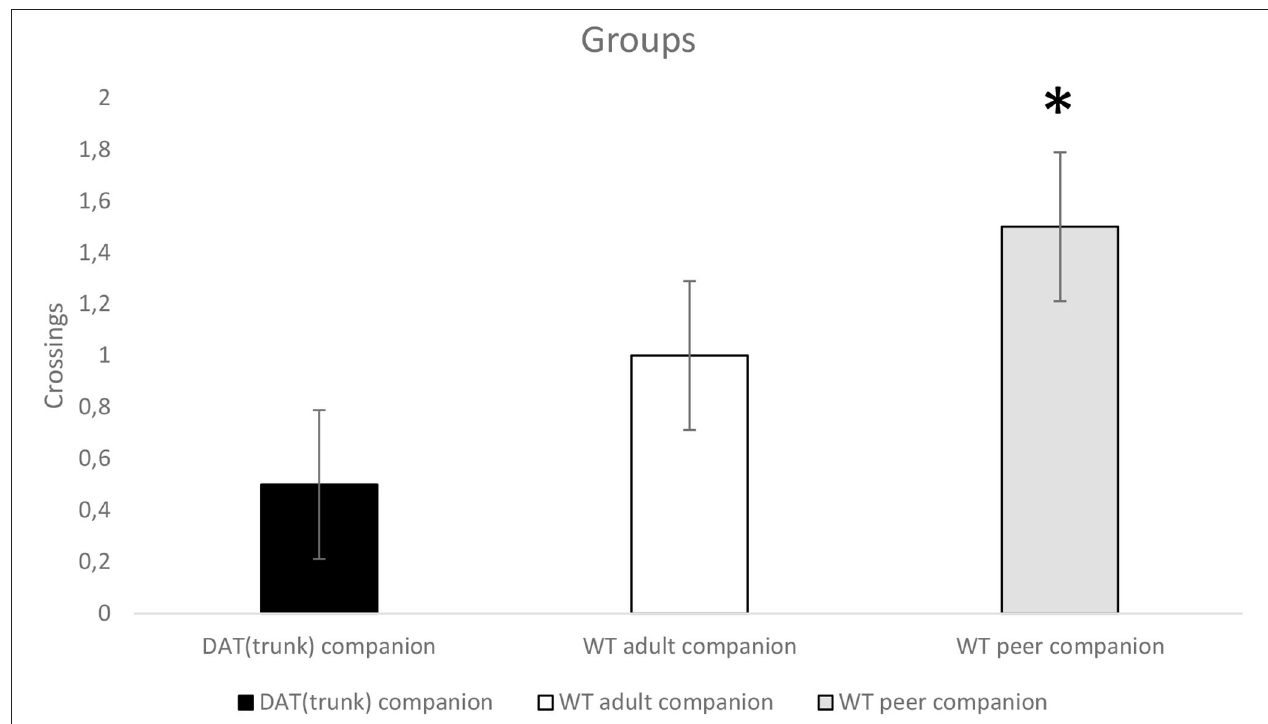
FIGURE 4 | Wild-type (WT) adolescent rats grown up with WT adolescent rats (gray) ( n = 8) cross more (* p < 0.06) than WT rats grown up with DAT trunk rats (black) ( n = 8) when they faced up both the 99-cm unstable bridge without the “step” and the 99-cm unstable bridge with the “step”.